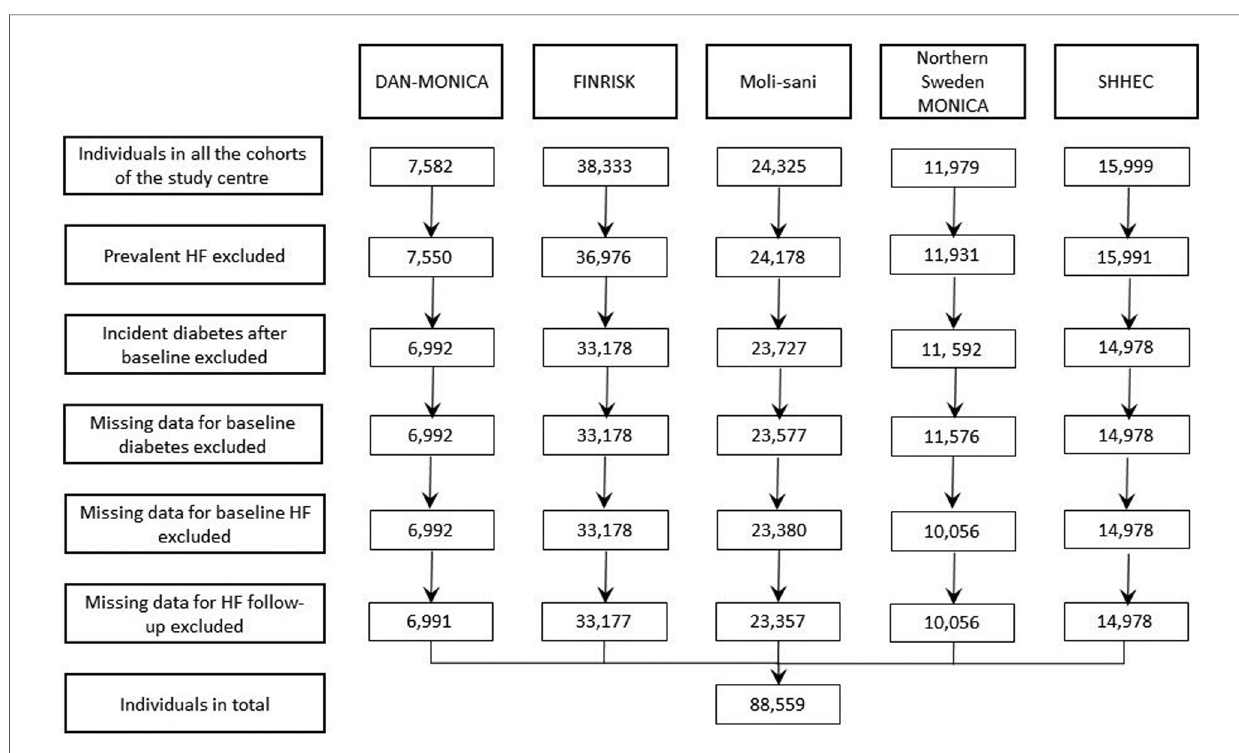
FIGURE 1 Flowchart of the numbers of participants from different MORGAM centers after data exclusion steps. SHHEC, Scottish Heart Health Extended Cohort; MONICA, Monitoring of Trends and Determinants in Cardiovascular Disease; HF, heart